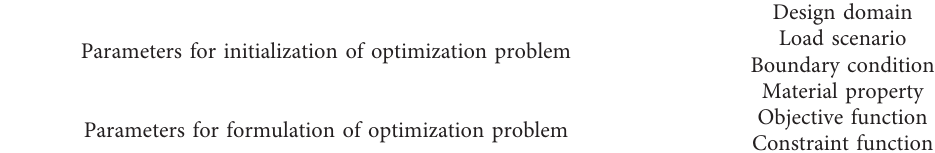
Table 1: Influential parameters for architectural morphology generation.